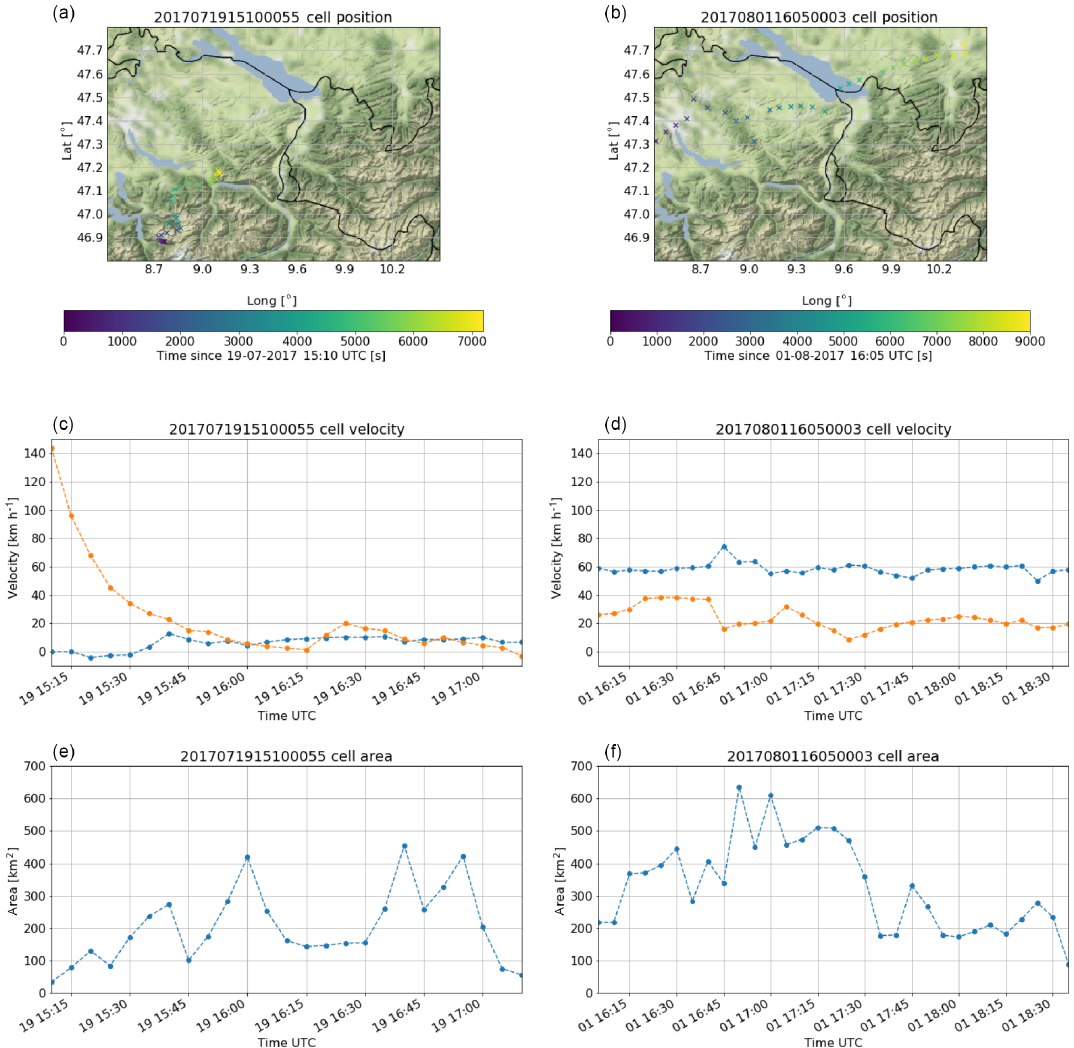
Figure 10. (a–f) Cell position, velocity (orange: south–north direction; blue: west–east direction) and area. (a, c, e) Cell 1; (b, d, f) cell 2.